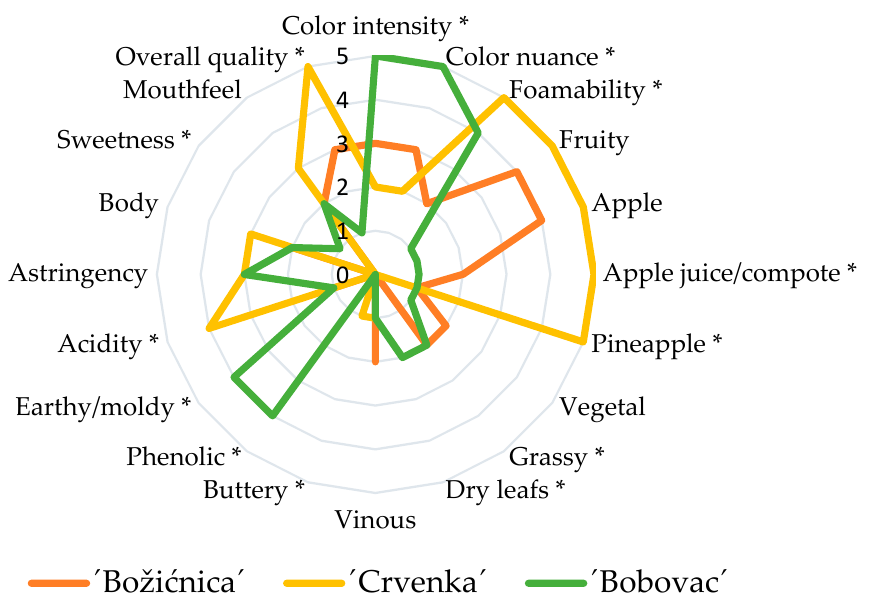
Figure 3. Sensory evaluation of Pét ‐ Nat ciders; * represents significant differences ( p ≤ 0.05) between the Pét ‐ Nat ciders.